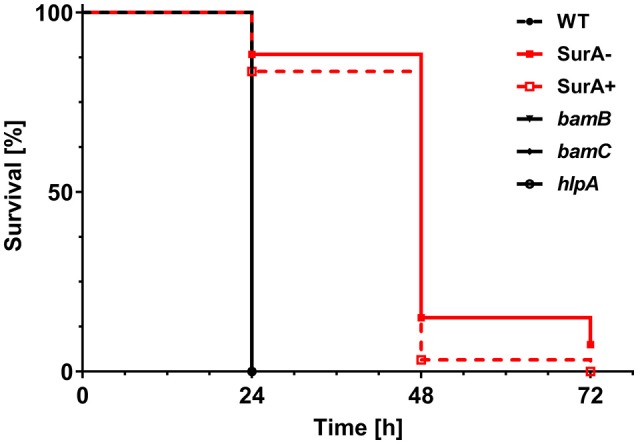
SurA deletion leads to attenuated virulence in the Galleria mellonella infection model. In total, 60 G. mellonella larvae per group were infected in 3 independent experiments with a CFU of 12 ± 2 for the indicated time period and survival of larvae was monitored by touching with a forceps. The conditional surA mutant strain was tested both when expressing SurA (SurA+) and after depletion of SurA (SurA–) at the time point of infection. Please note that the survival curves of WT, bamB, bamC, and hlpA are identical. Statistical analysis was performed using a log rank test (Mantel-Cox test). A significant difference between WT and the conditional surA mutant was observed (p < 0.0001).